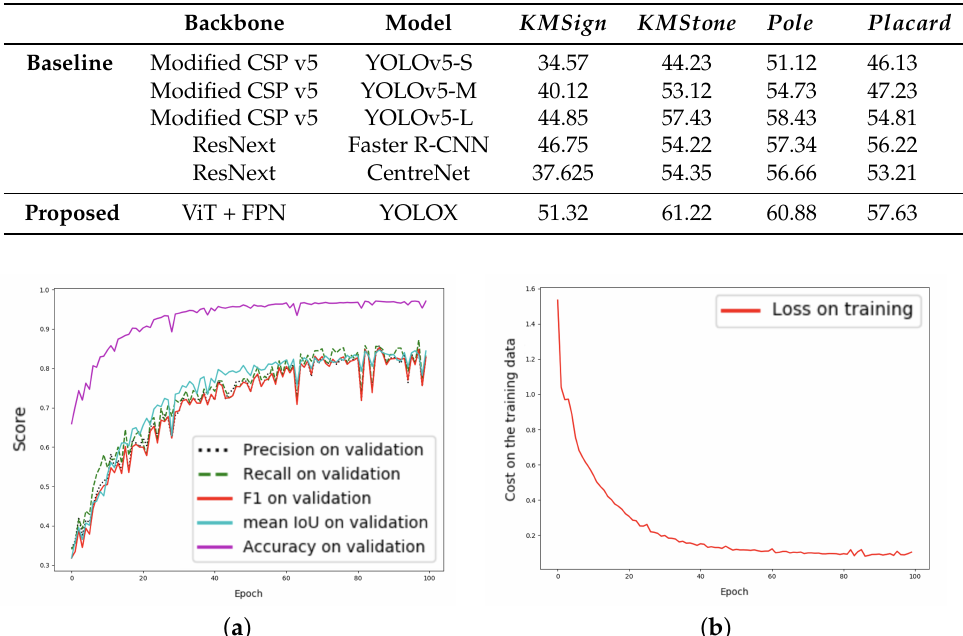
Table 3. Comparison of the average precision between the results of four categories after subsequent operations on Road Asset test-dev corpus.